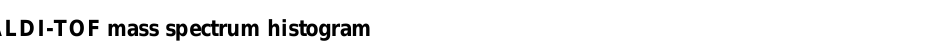
Figure 3: MALDI-TOF mass spectrum